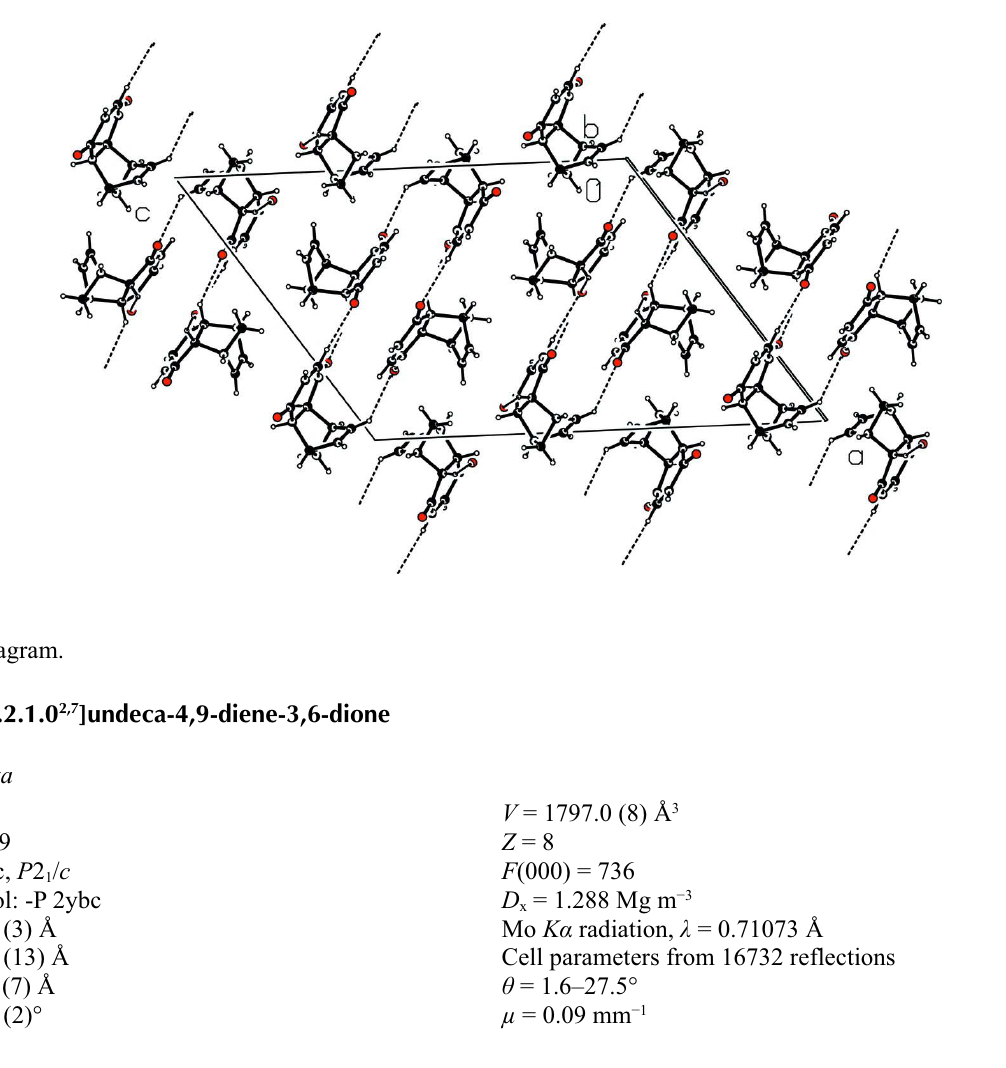
The asymmetric unit of the title compound, showing atoms labelling. Displacement ellipoids are drawn at the 50% probability level.